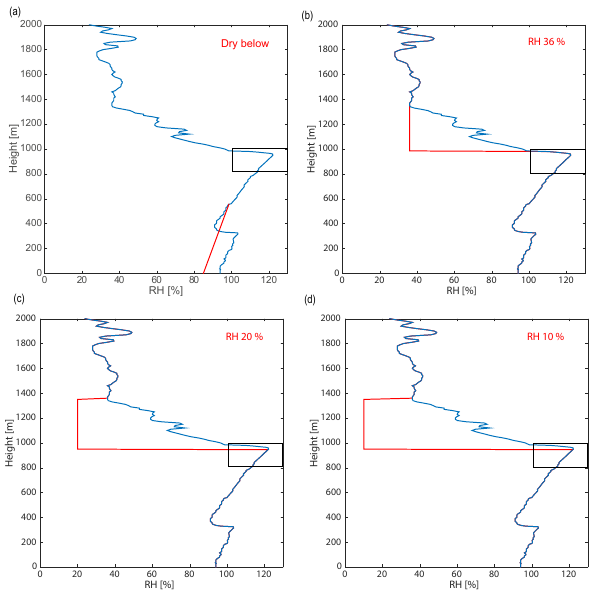
Figure 3. RH profiles for the sensitivity experiment SensMoist sim- ulations. Modified parts of the RH profile are shown in red. The initial RH profile is in blue. (a) RH profile for the simulation with dry-air advection below the cloud. Panel (b) shows the RH profile of the simulation with the dry-air advection above the cloud with the RH of 36%; panels (c) and (d) show simulations with the dry-air ad- vection above the cloud with the RH of 20 and 10%, respectively. The black boxes mark the vertical extent of the liquid cloud layer of the control simulation.